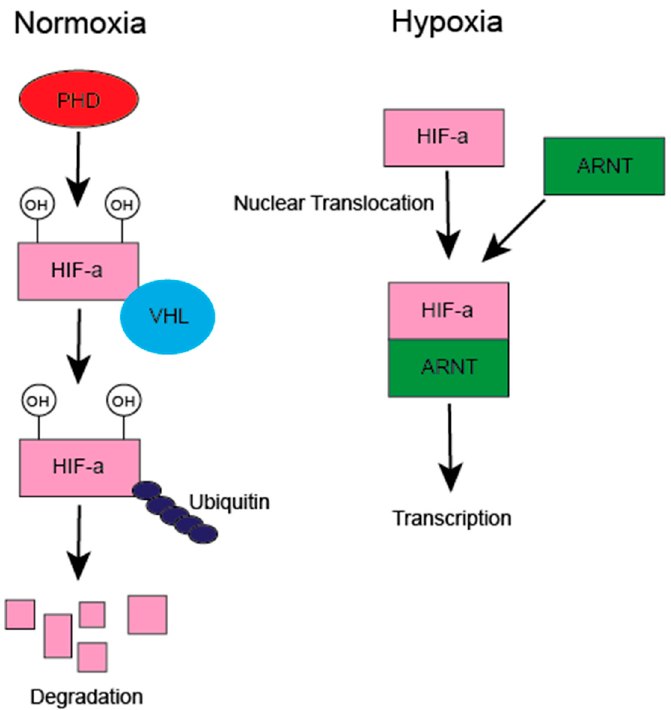
Figure 1. Under normal oxygen concentrations, hypoxia-inducible transcription factors (HIFs) are hydroxylated on two specific proline residues by prolyl hydroxylase domain (PHD) enzymes (HIF1 α P402 / P564; HIF2 α P405 / P531), leading to their association with von Hippel-Lindau (VHL), ubiquitination, and proteasomal degradation. In tumors, as oxygen concentrations become limiting, the lack of molecular oxygen leads to HIF stabilization, dimerization with alpha subunit and a beta subunit (ARNT), nuclear translocation, and target gene transcription. In neutrophils, HIFs can also be stabilized in normoxic conditions by inflammatory microenvironments and inflammatory factors, such as bacterial lipopolysaccharide.